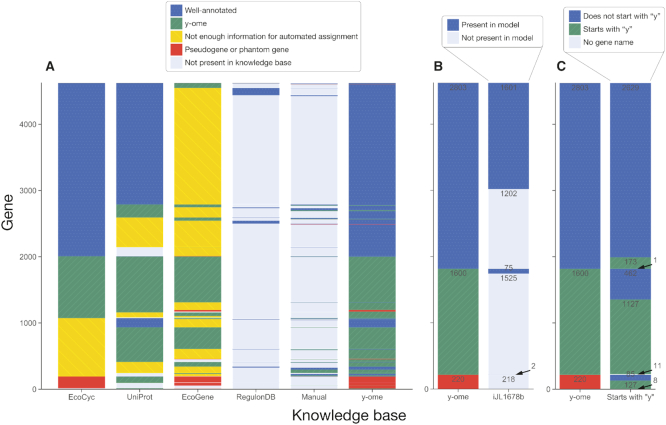
Gene annotation across knowledge bases. The y-axes represent all unique genes in the database. Gene order is maintained within each subplot so one can track the annotation of a set of genes across knowledge bases. (A) An automated approach was used to categorize genes from each database as ‘Well-annotated’ or ‘y-ome’ based on the definition of the y-ome. Pseudogenes and phantom genes were excluded. The resulting y-ome includes 1600 genes. (B) y-ome categories were compared to the content of the latest E. coli genome-scale ME-model. (C) A total of 173 genes have primary names that start with ‘y’ but are well-annotated, and 462 genes in the y-ome have non-‘y’ primary names.